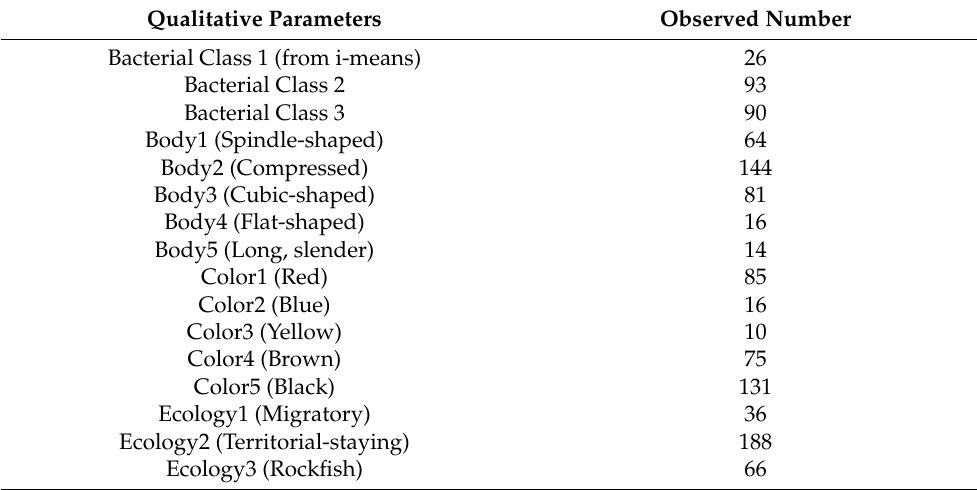
Table 1. Added qualitative information and sample